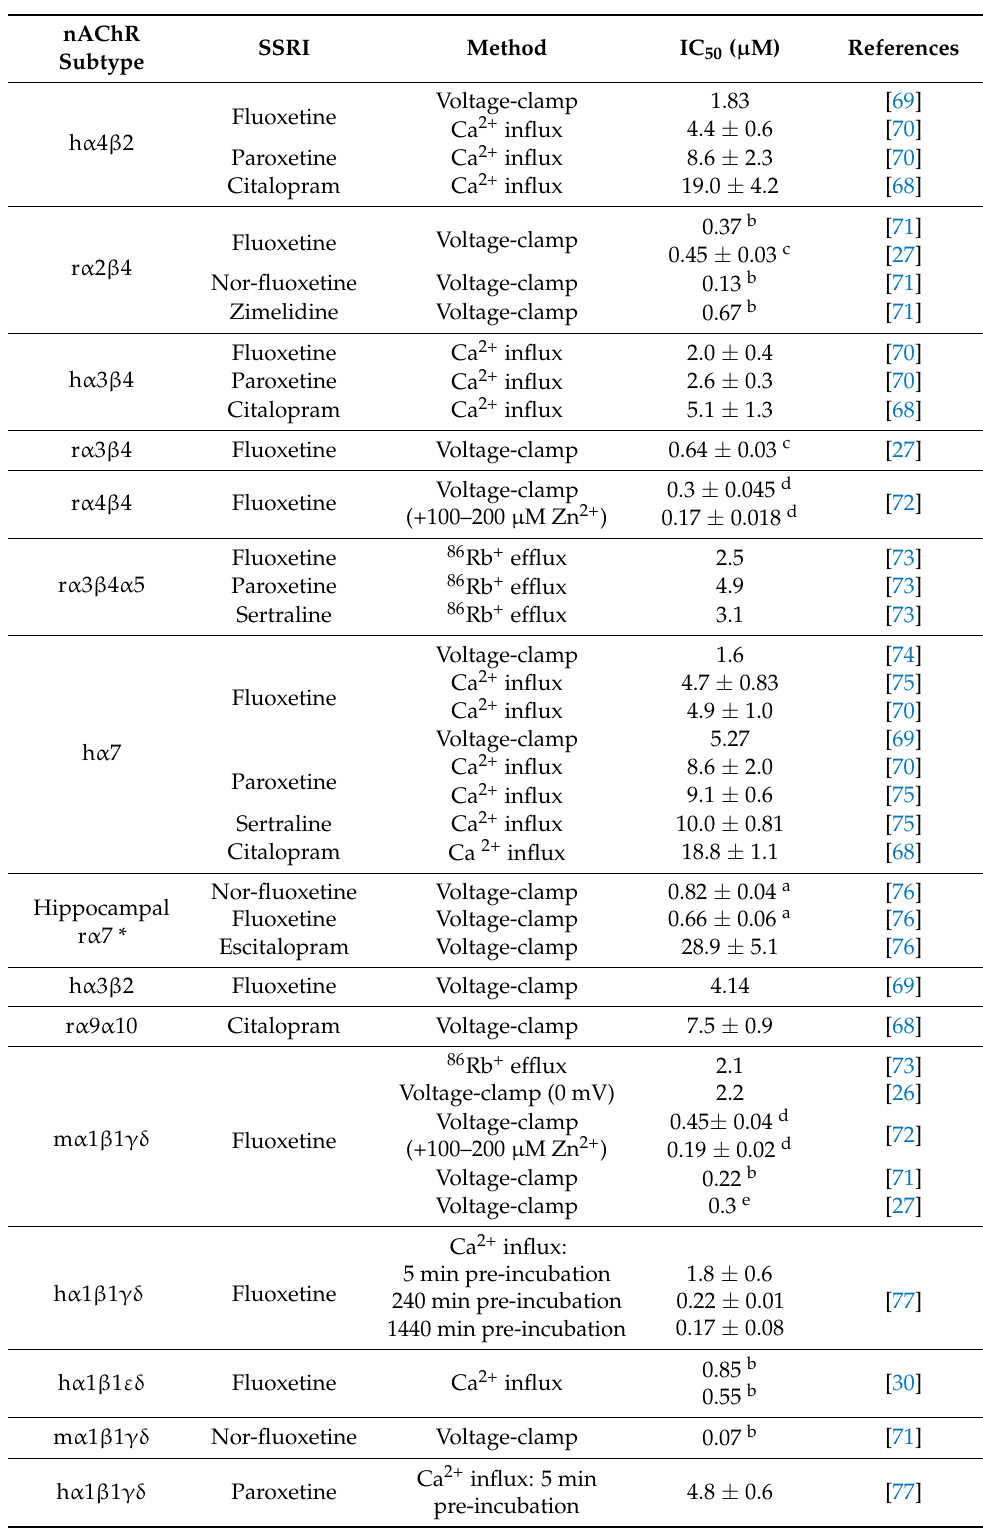
Table 1. Inhibitory potency (IC50) of SSRIs for different nAChR